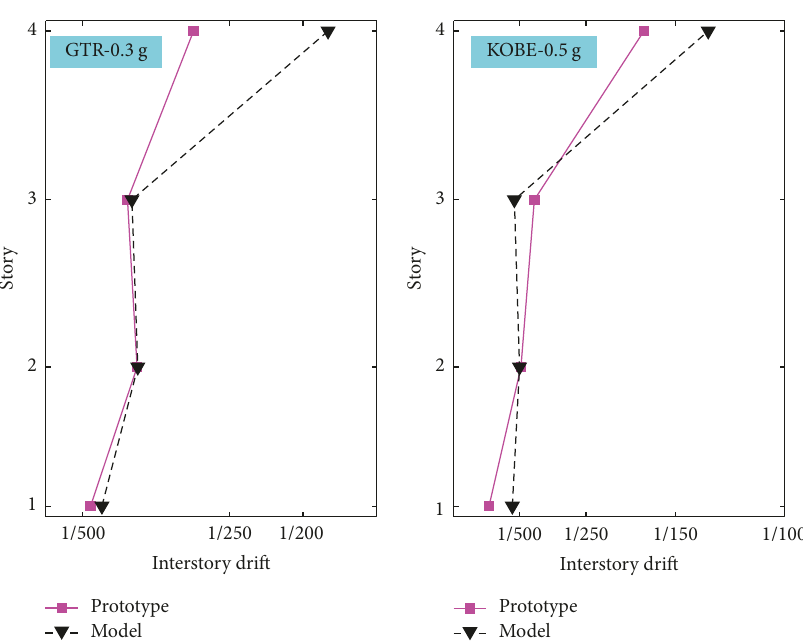
Figure 19: Interstory drift of the prototype structure and test model structure under moderate and rare earthquakes.